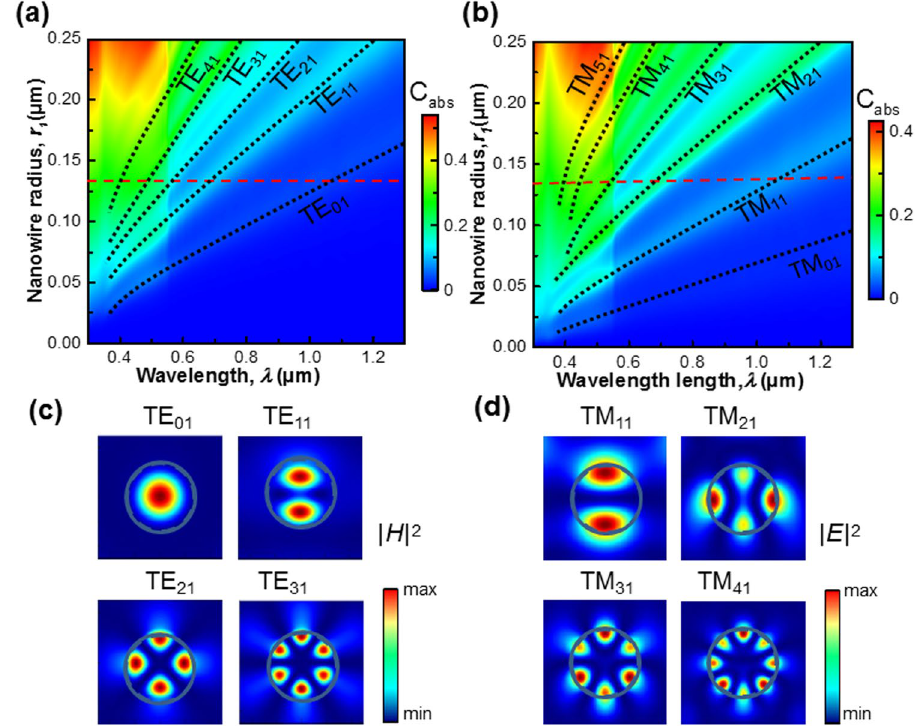
Figure 2. Graphs illustrating the tunability of the absorption resonance peak for single NW. Two-dimensional plot of calculated absorption cross section as a function of wavelength and radius of the NW for TE ( a ) and TM ( b ) modes. The dashed black lines represent the different leaky modes at the wavelength between 300 and 1300 nm. ( c ) The configuration of the magnetic field intensity for typical TE leaky modes. ( d ) The configuration of the electric field intensity for typical TM leaky modes. The blue solid circles and dashed circles represent the ZnTe/ZnO interface and ZnO/air interface,